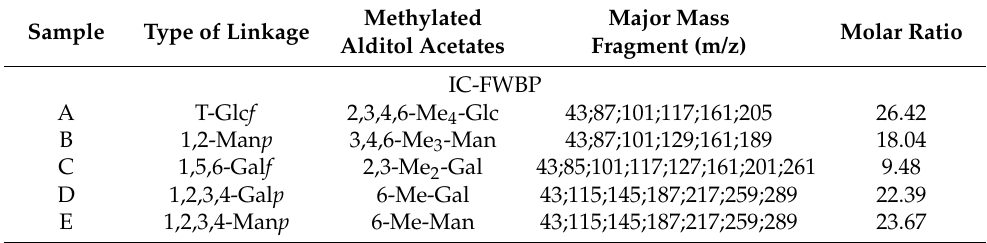
Table 2. GC-MS data for methylated sugar moieties of the